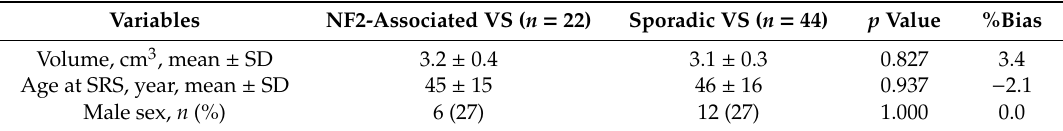
Table 5. Parameters used for propensity score matching and the percentage bias between cohorts. * Values of p < 0.05 are considered statistically significant. NF2 = neurofibromatosis type 2; VS = vestibular schwannoma; %bias = percentage bias; SD = standard deviation.